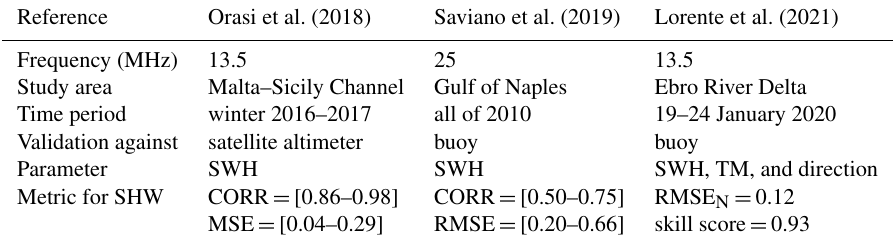
Table 1. Review of the most recent studies about validation of wave parameters derived from high-frequency radar (HFR) against independent wave observations. Skill metrics obtained for the significant wave height (SWH) during the studied period included the mean squared error (MSE), the root mean square error (RMSE), the normalized RMSE (RMSE N ) , the Pearson’s correlation coefficient (CORR), and the skill score (SS) proposed by Wilmott (1981). The metric intervals denote the range of results obtained for several sites composing each HFR